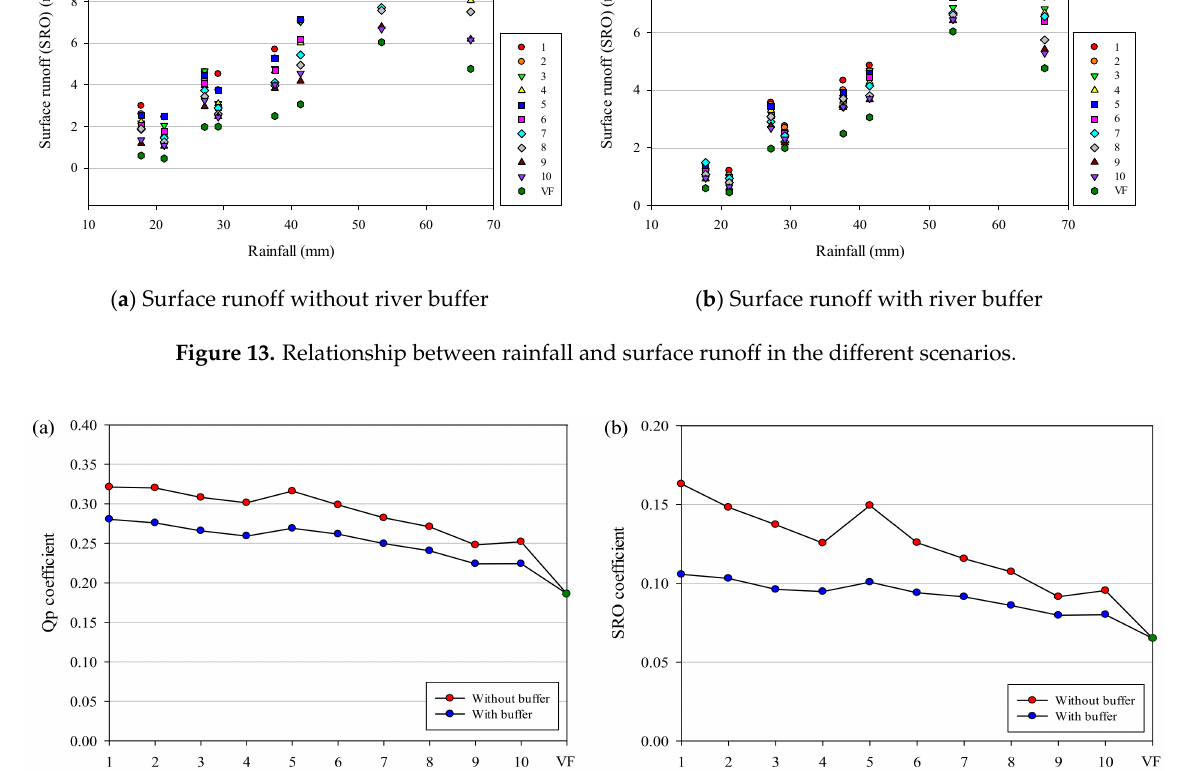
Figure 14. ( a ) Coefficient of Qp to peak rainfall intensity. ( b ) Coefficient of total SRO to the amount of rainfall.